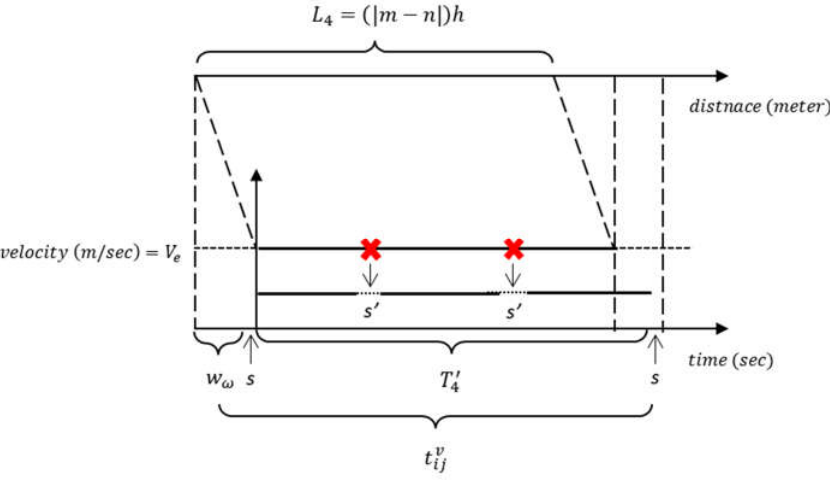
Figure 3. Travel time calculation of vertical movement with two intermediate stops.